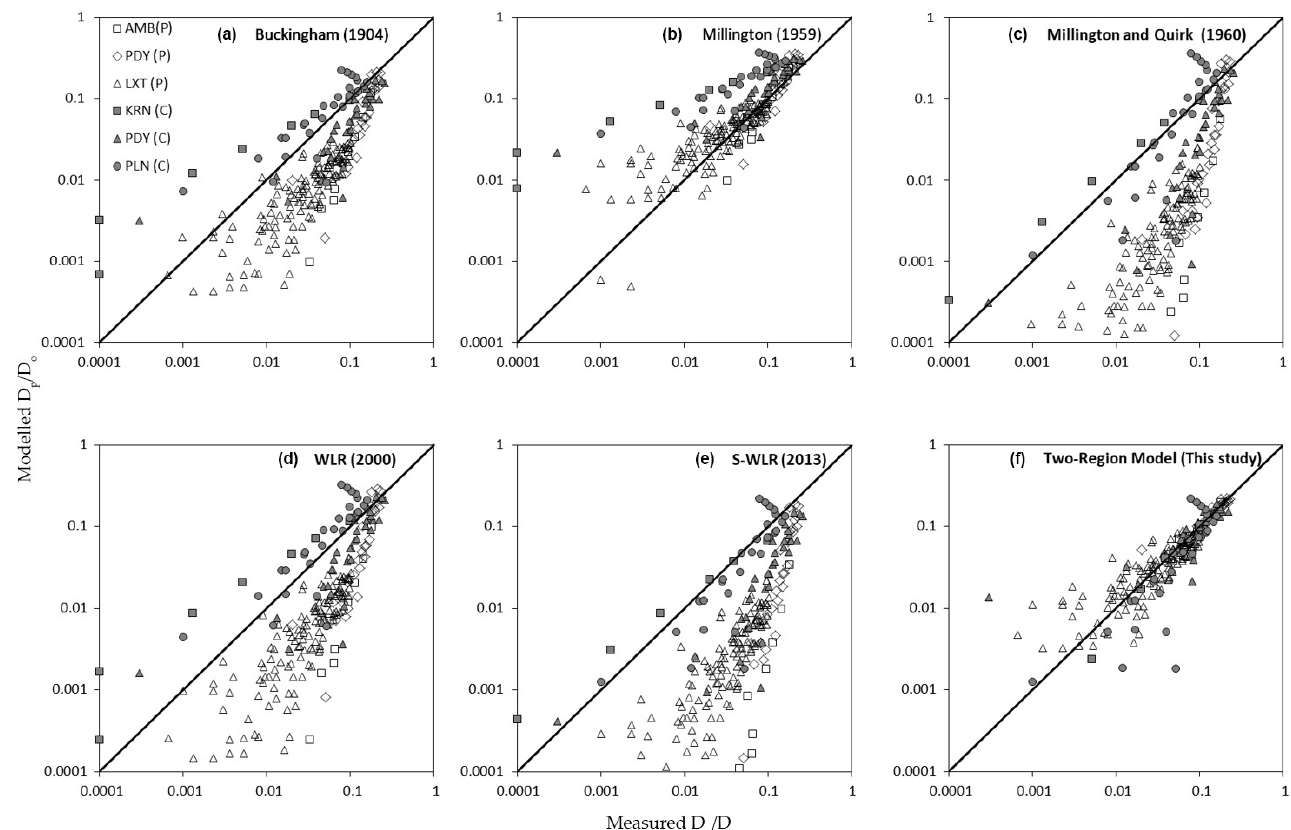
Figure 03 Figure 3. Scatterplot showing the measured and modeled D p /D o for intact soils using six predictive- descriptive models ( a – f ). AMB; Ambewela (Sri Lanka), PDY; Peradeniya (Sri Lanka), LXT; Lexington (United Kingdom), KRN; Kurunegala (Sri Lanka); PLN; Polonnaruwa (Sri Lanka). P and C